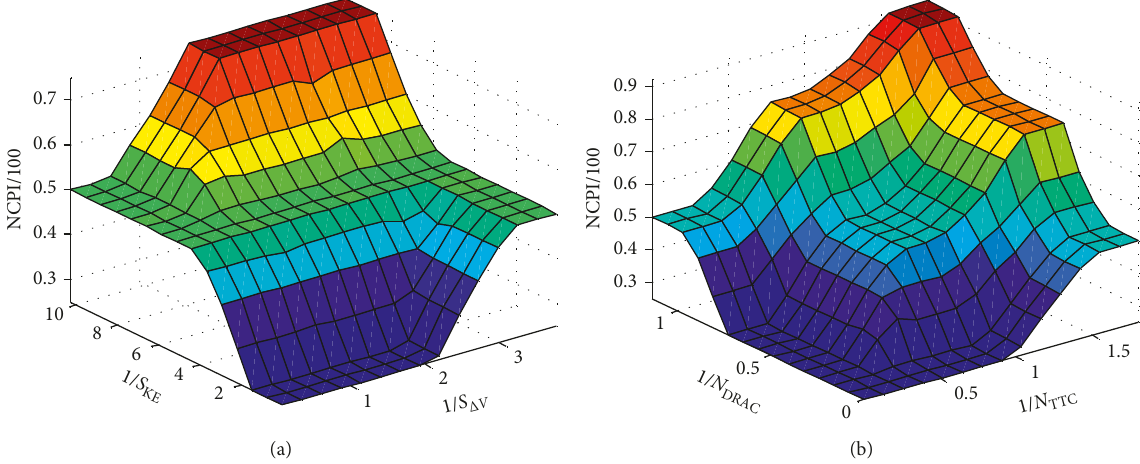
Figure 6: The 3D profiles of NCPI and its variables. (a) Severity estimation variables; (b) number estimation